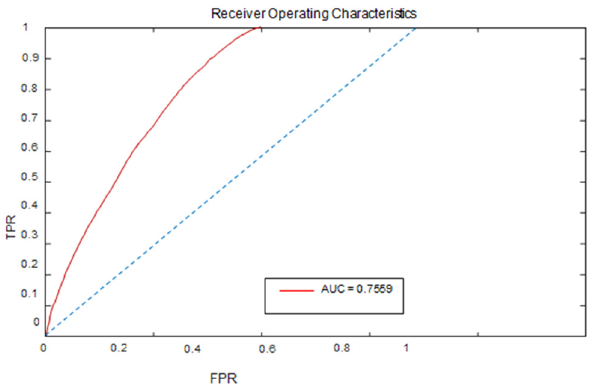
Figure 6: The fi rst scenario medium accurate detector.